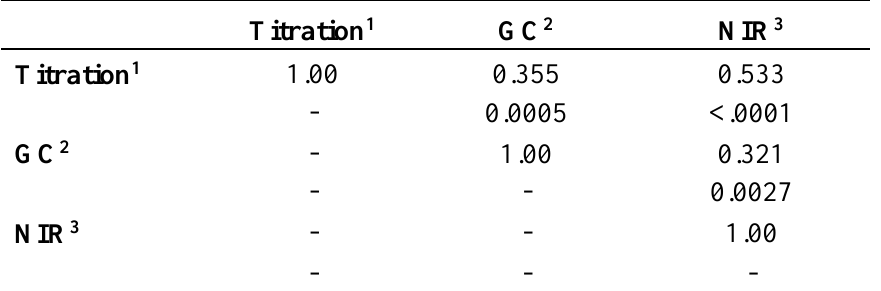
Table 11 . Pearson Correlation Coefficients and P-values for